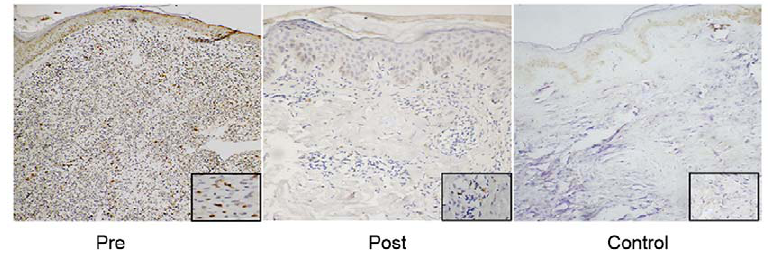
Figure 3. Immuno-histochemical staining of IL-17. A light microscopic analysis of IL-17 immuno-staining in dermal tissue lesion sections of PKDL at pre-treatment, post-treatment stages and normal skin of healthy individuals. Intense IL-17 staining was observed within the inflammatory infiltrate at pre-treatment stage in PKDL. Magnification 10 6 (inset 40 6 ).